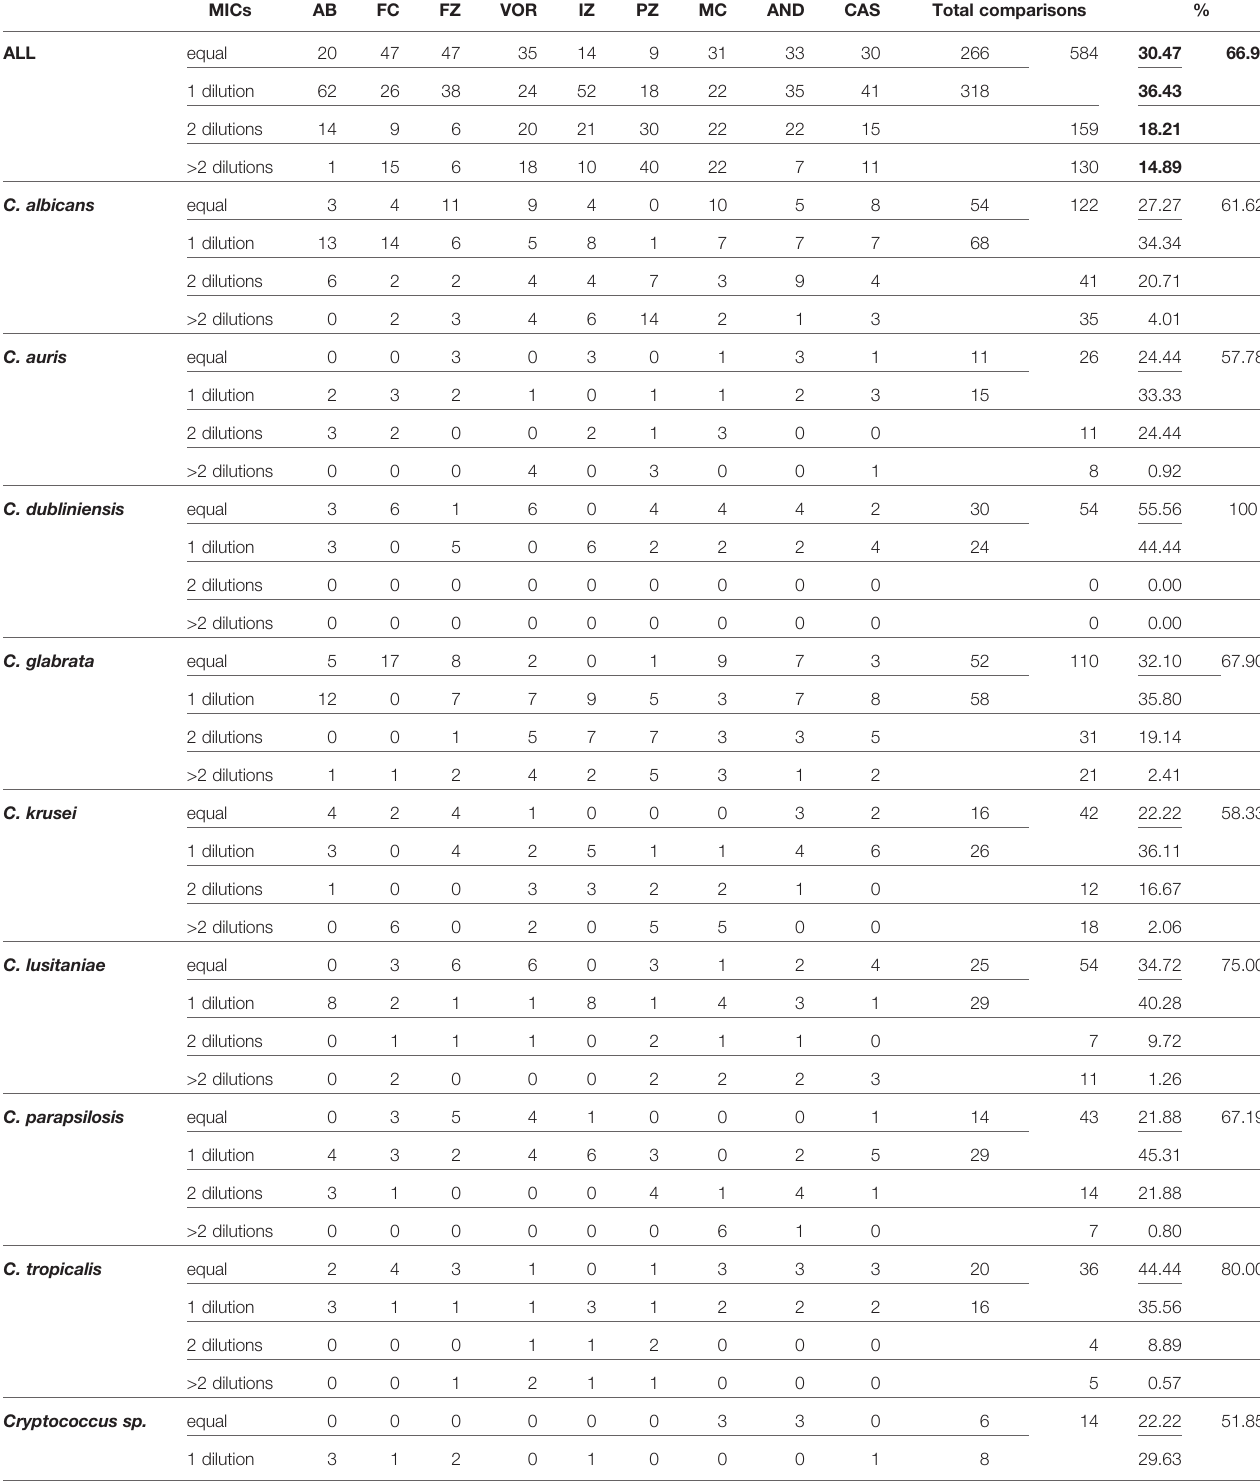
TABLE 1A | Comparisons of MIC between YeastOne Sensititre and Micronaut-AM read visually.